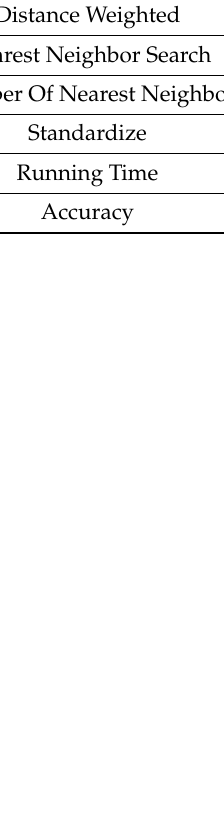
Table 4. Comparison table of model parameters used by the time-frequency domain for the propeller fault. 1